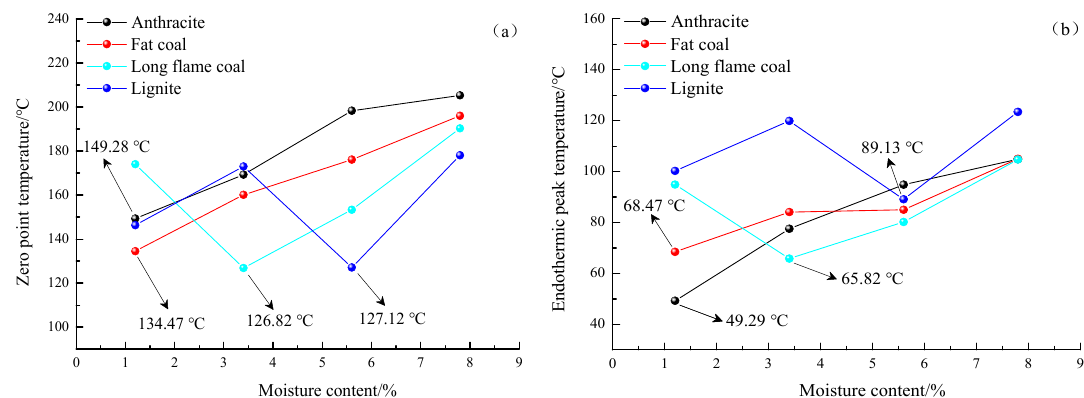
Figure 9. The curves of zero point temperature ( a ) and endothermic peak temperature ( b ) for anthracite, fat coal, long flame coal and lignite at four different low moisture contents.